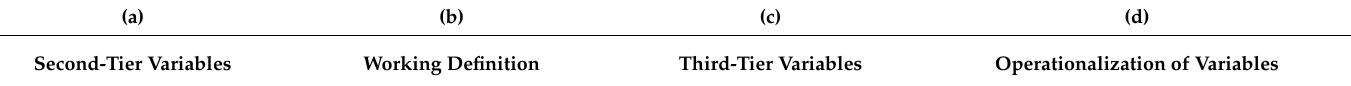
Table 3. Third-tier variables of the governance system ( GS ), as identified by